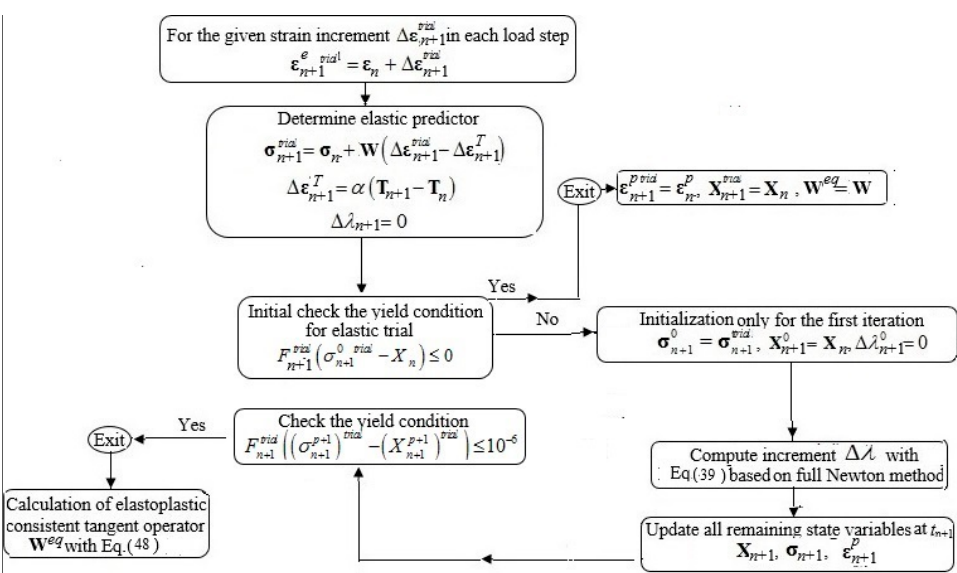
Figure 3. Flow diagram of the proposed solution algorithm implemented in user subroutine UMAT.